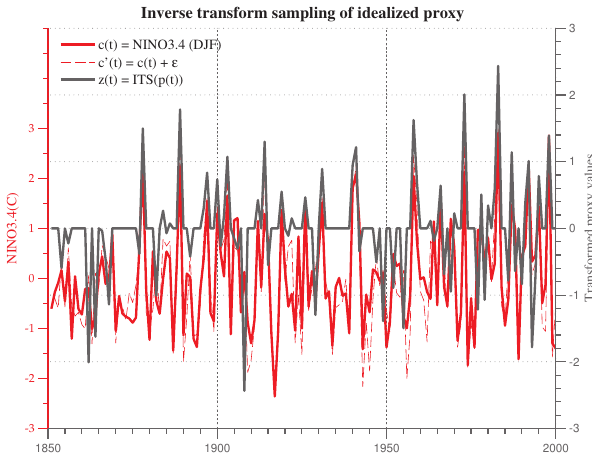
Figure 2. Correcting for non-normality using inverse transform sampling. Solid red: the normalized NINO3.4 index; dashed red: standardized NINO3.4 with additive N (0 , 0 . 25) noise; grey: the transformed version of the pseudo-proxy depicted in Fig. (1). Be- cause the distribution of p ( t ) has a mass point at 0, we com- pute the transform only on those time points where p ( t ) > 0, leav- ing it 0 otherwise. Code for implementing the transform is avail- able at https://github.com/CommonClimate/common-climate/blob/